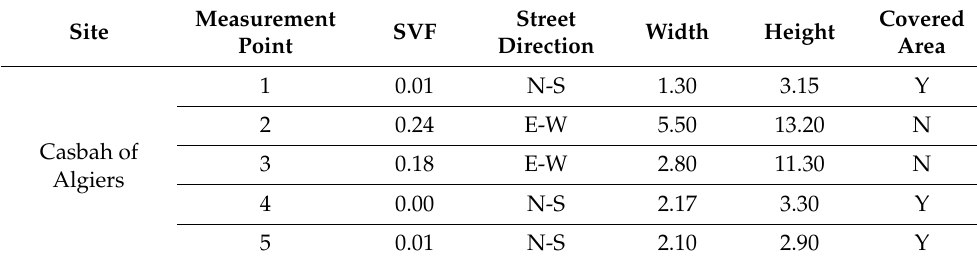
Figure 4. Map of the selected points in the Upper Casbah. Table 1. Morphological characteristics of sites and measurement points.